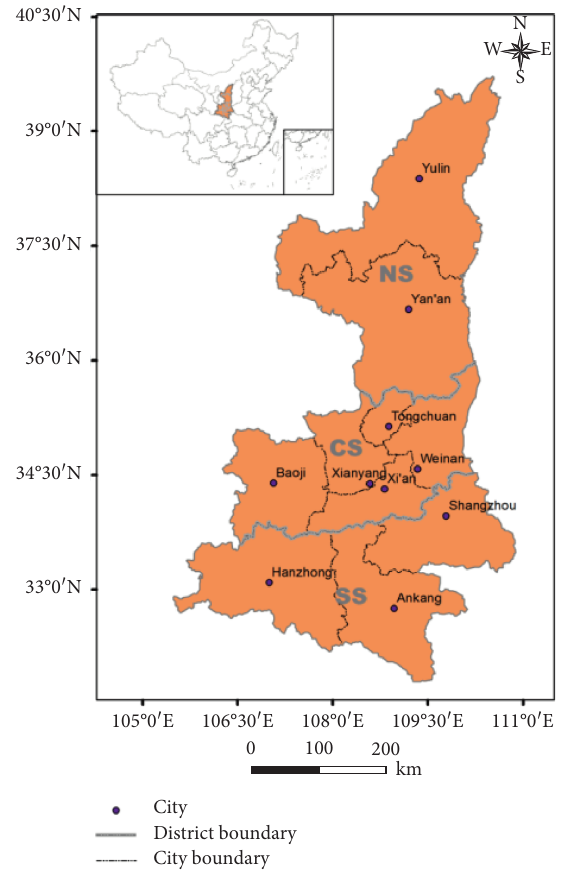
Figure 1: The domain of the study area. The gray boundaries separate the study area into three regions. NS represents the northern region of Shaanxi Province, CS represents the central region of Shaanxi Province, and SS represents the southern region of Shaanxi